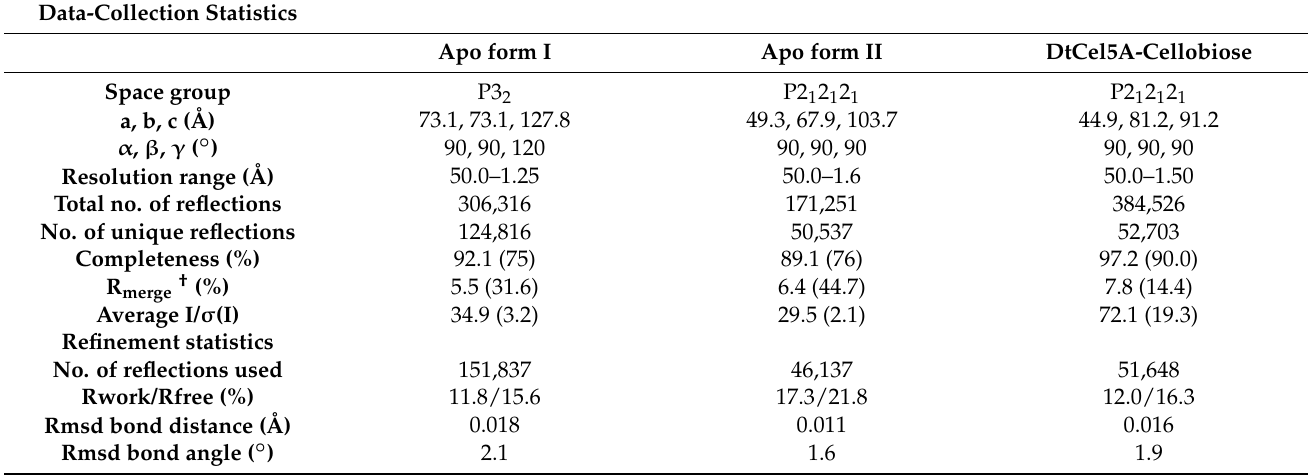
Table 1. Data-collection and refinement statistics. Values in parentheses are for the highest resolution